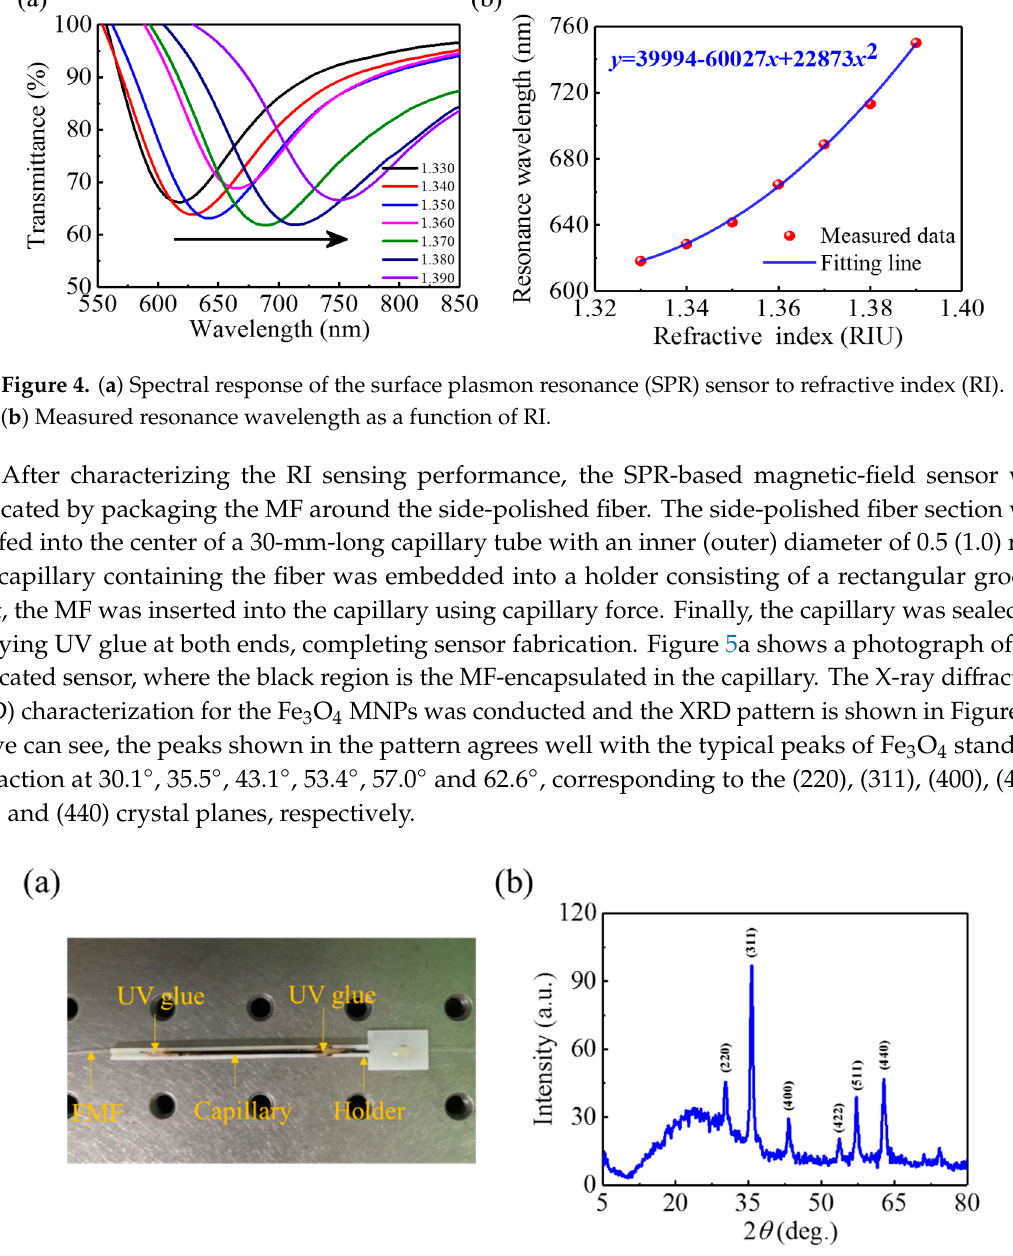
Figure 5. ( a ) Photograph of the fabricated sensor on an optical table. ( b ) XRD pattern for the Fe 3 O 4 MNPs.